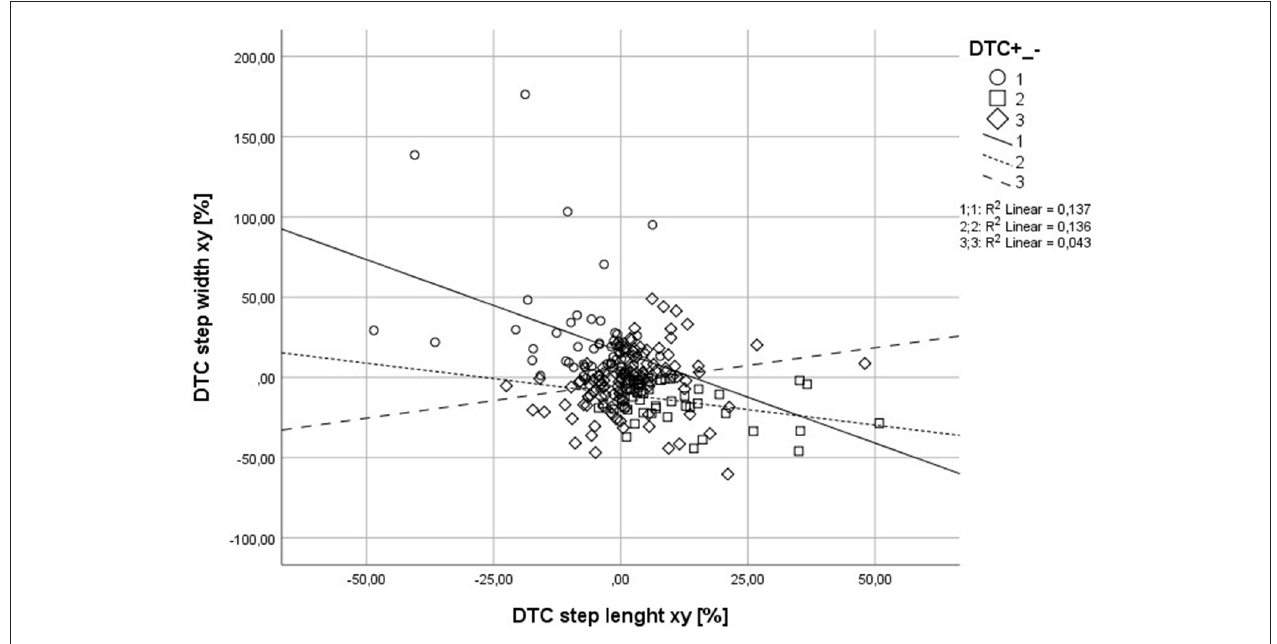
FIGURE 2 | This image shows that participants with negative DT costs (DTCs) had greater decrements for step width and step length than the other two groups, whereas participants with positive DTC revealed improved step length with reduced step width. The non-uniform participants were between the two other